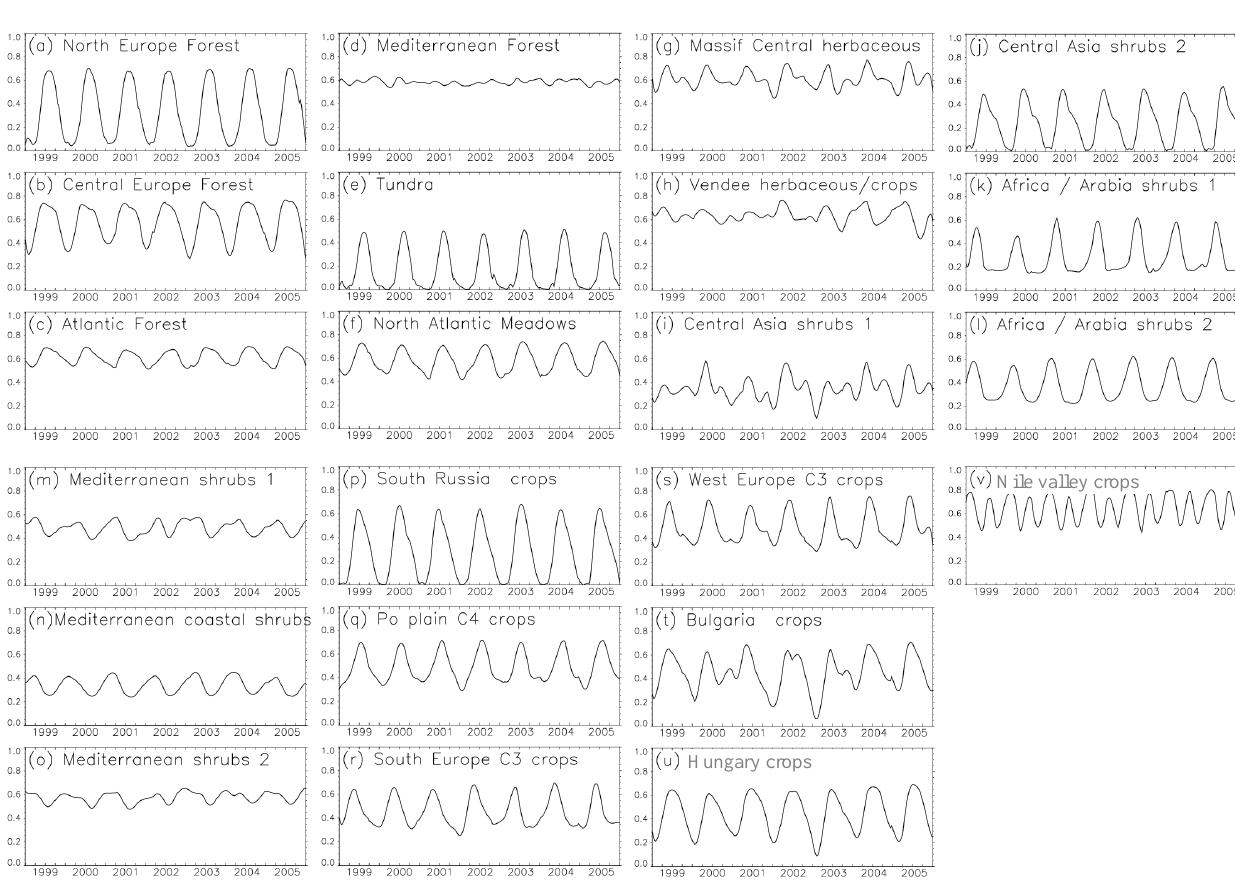
Fig. 6. Examples of NDVI profiles for several covers of Figure 6. Examples of NDVI profiles for several covers of ECOCLIMAP-II/Europe.